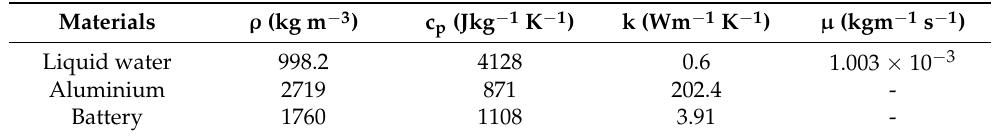
Table 2. Material